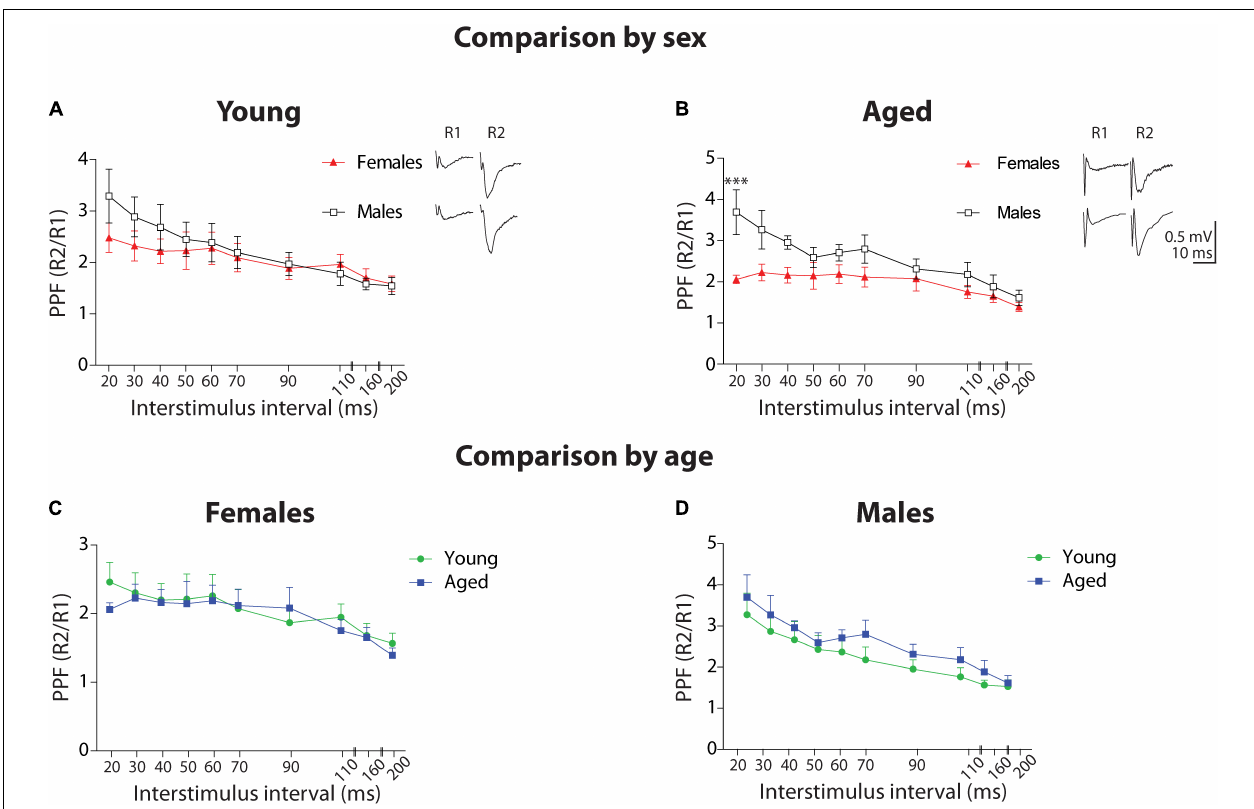
FIGURE 3 | Short-term plasticity at Schaffer collateral-CA1 synapse of young and aged female and male degus. Comparison by sex. (A–D) Paired-pulse facilitation (PPF) obtained by plotting the R2/R1 ratio at different interstimulus intervals between 20 and 200 ms, in young (A) or aged (B) female and male degus ( n = 5 ). Comparison by age . PPF plot in young and aged female (C) or male (D) degus ( n = 5 recordings at 20 ms ISI (scale: 0.5 mV, 10 ms). *** p < 0.001; black and red symbols represent the comparison by sex; green and blue symbols correspond to the ♂ comparison by